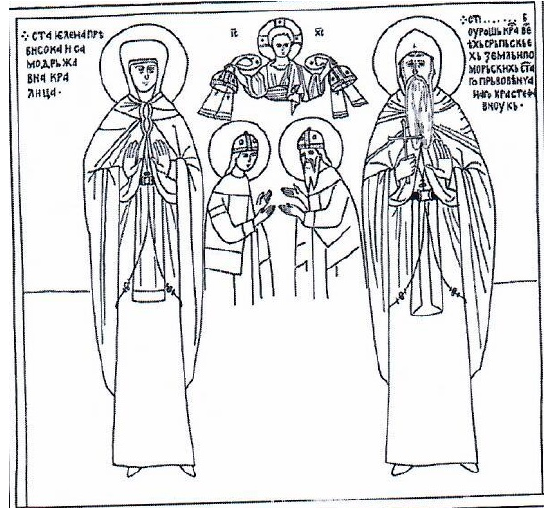
Figure 11. Queen Helen as a nun with Uroš I as monk. Between them, a young king Stefan Uroš IV Dušan and his father Stefan III De č anski, around 1322. Church of the Annunciation of Gra č anica Monastery, north part of the eastern wall. Reconstruction based on drawings by B. Živkovi ć .